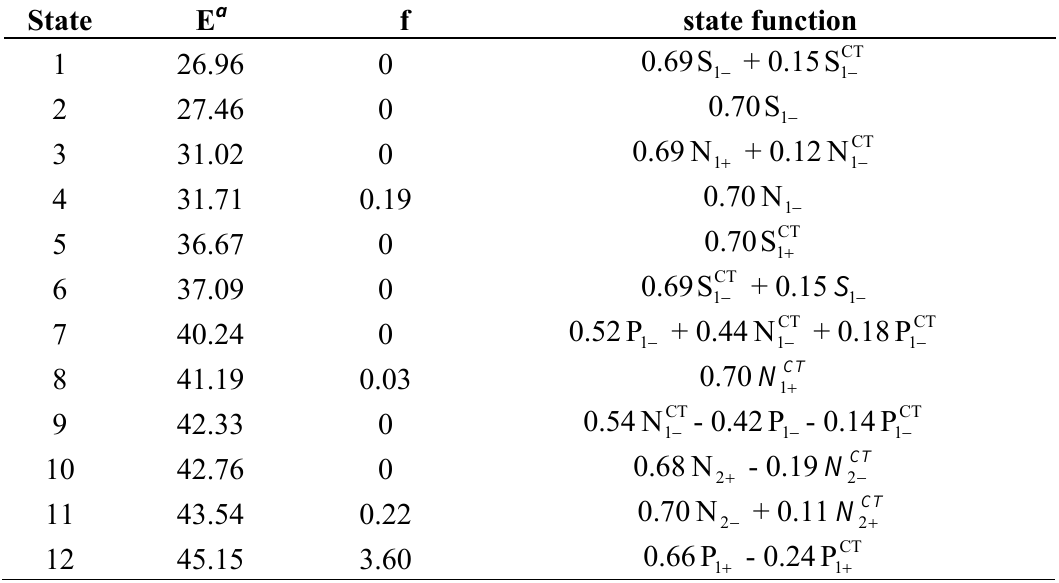
Table 4. Calculated Electronic Transitions for [2,2]Biphenylenophane in H-Aggregation, the Face-to-Face Arrangement. [51]. Reproduced with permission from American Chemical